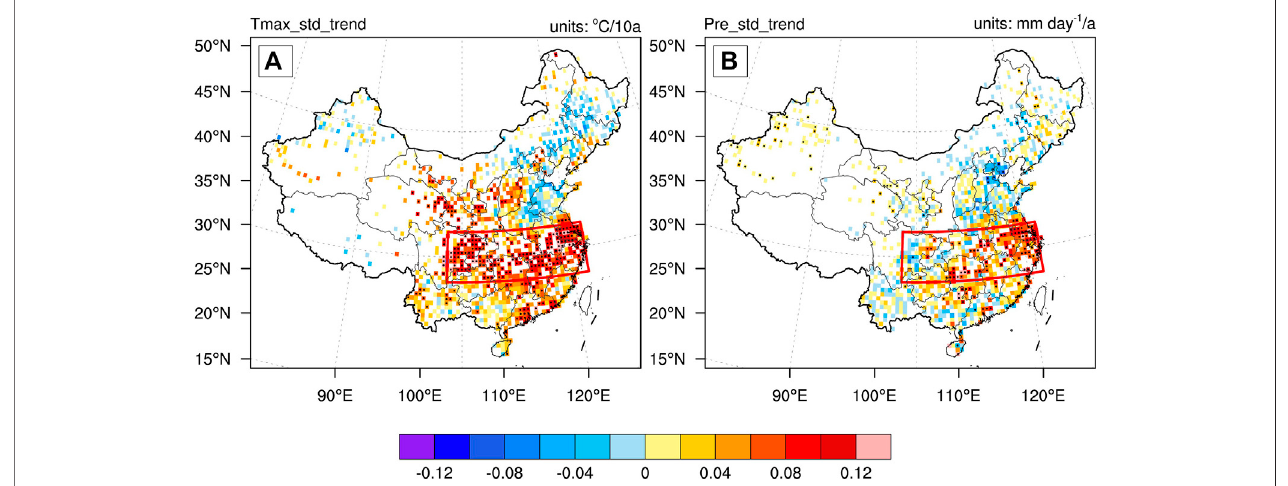
FIGURE 6 | The trends of the standard deviations of Tmax (A) , units: ° C/10a; and precipitation (B) , units: mm day − 1 /a at summer days (June-July-August) during 1961 – 2017. The meanings of stippling regions and the red boxes are the same as Figure 1 .